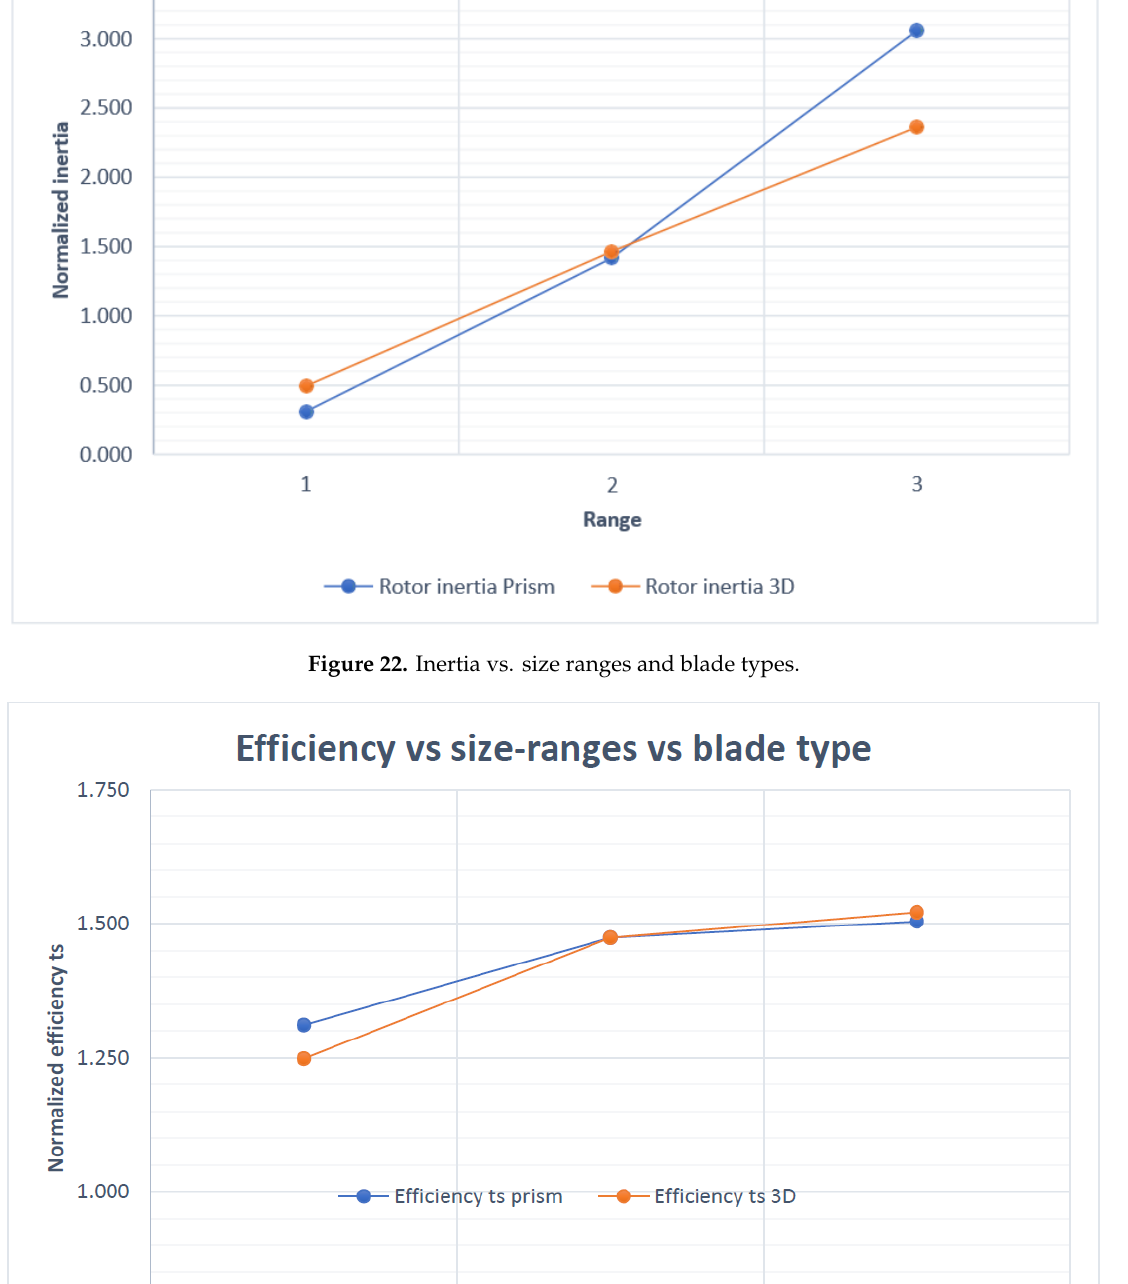
Figure 23. E ffi ciency vs. size ranges and blade